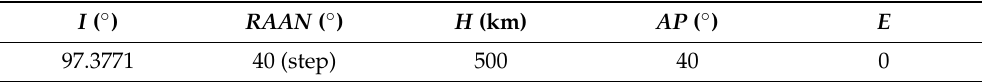
Table 2. Number of constellation design orbits.